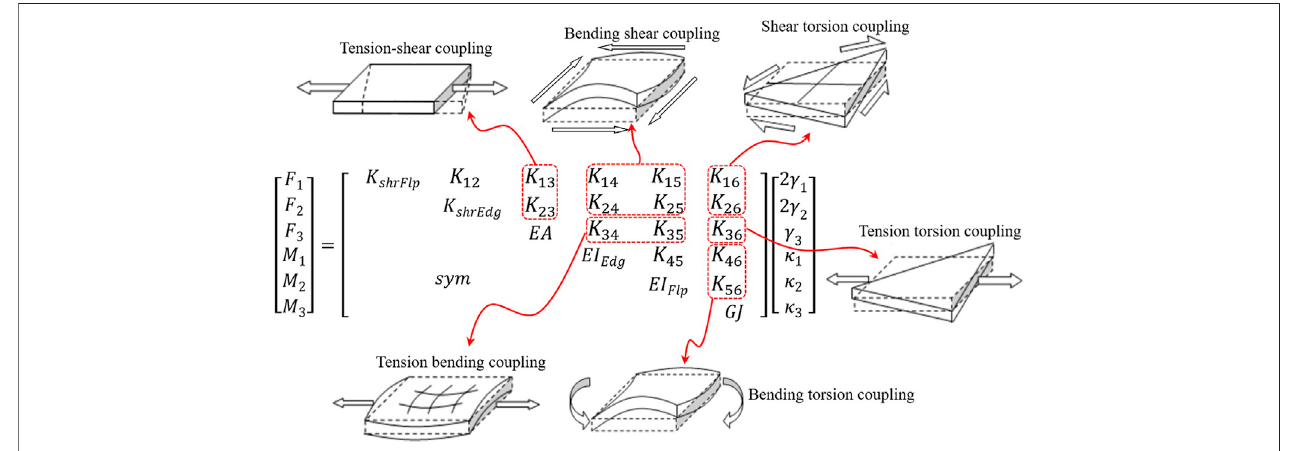
FIGURE 1 | Stiffness matrix of composite beam